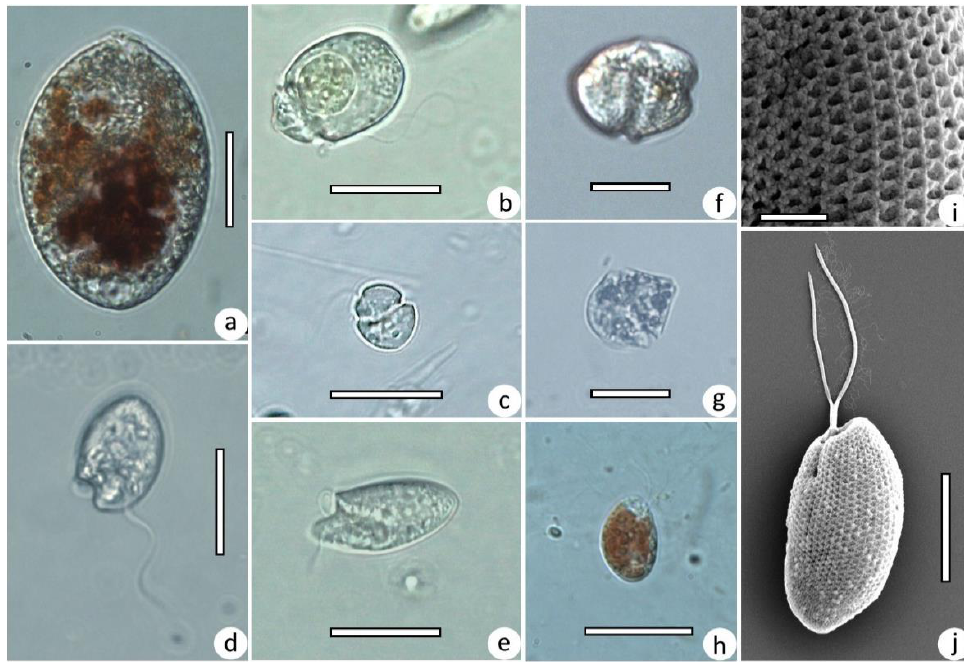
Figure 5. Morphology of the Dinoflagellata, Cryptophyta, and Colponemida flagellates observed: ( a ) Prorocentrum sp.; ( b ) Amphidinium crassum ; ( c ) Gymnodinium sp.; ( d , e ) Oxyrrhis marina ; ( f , g ) Scrippsiella trochoidea ; ( h , i , j ) Rhodomonas cf. baltica (LM — h ; SEM — i , j ). Scale bars: 1 µm — i ; 5 µm — j ; 20 µm — a – h .